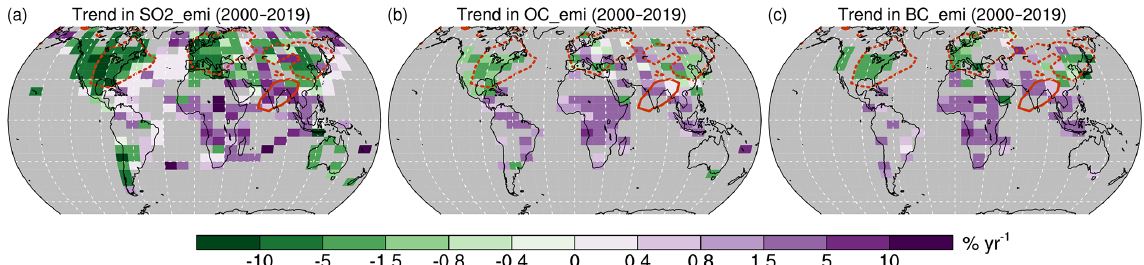
Figure 1. Linear trends (2000 to 2019) of (a) anthropogenic emissions in sulfur dioxide (SO 2 ) from the Community Emissions Data System (CEDS v_2021_04_21; Hoesly et al., 2018). Panels (b) and (c) are the same as (a) , but for anthropogenic emissions in organic carbon (OC) and black carbon (BC), respectively. Regions with small absolute trends (less than 7µgm − 2 d − 1 yr − 1 ) are masked by grey shading. Isolines enclose regions with trends in clear-sky solar ERF (see later, Fig. 4) larger than 0.05Wm − 2 yr − 1 in absolute terms. The average values in these regions are shown in Fig. 6, listed in Table 1, and discussed in Section7. A figure that combines the panels of Figs. 1 to 4 is provided as Supplement. A figure that shows the trends in absolute units is also provided as